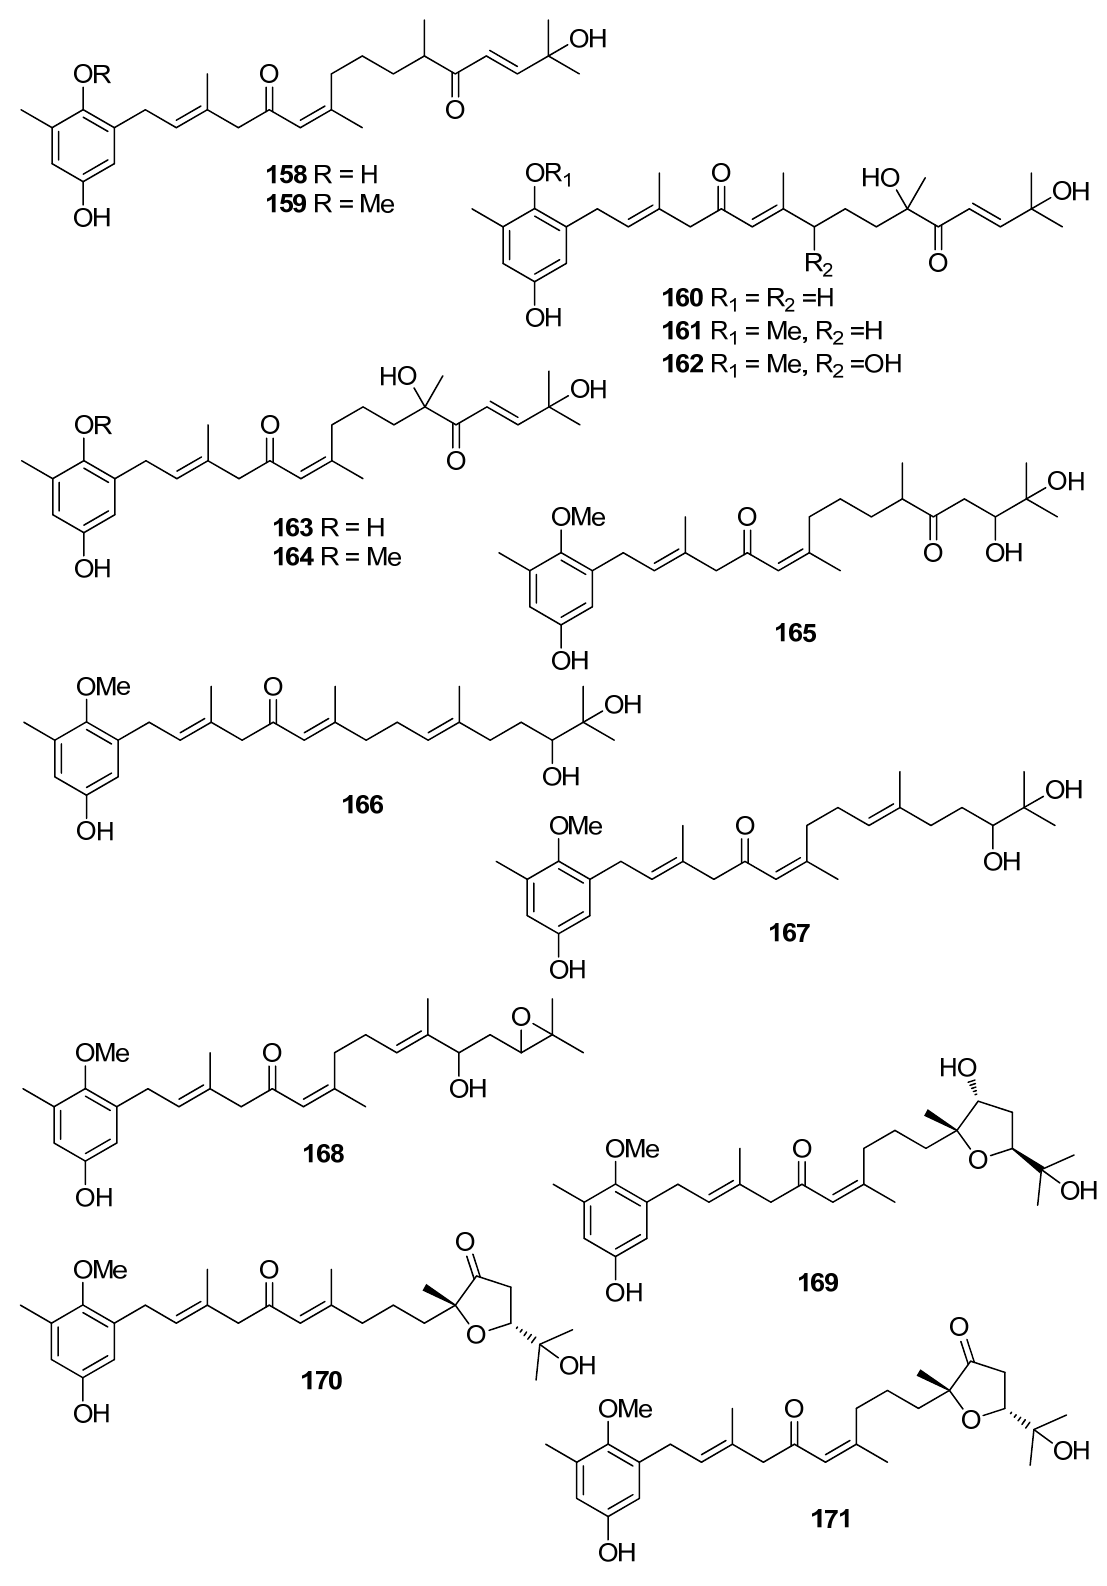
Figure 15. Chemical structures of compounds 158 – 171 .